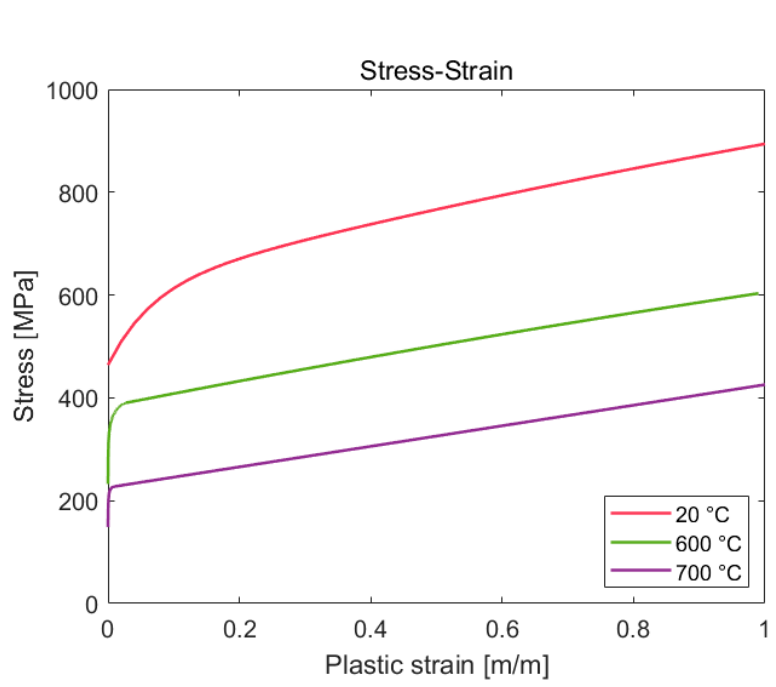
Figure 15. API X65 extended stress–strain curves, at different temperatures. Table 8. Material parameters of the linear–exponential formulation of the API X65 constitutive behavior, at different